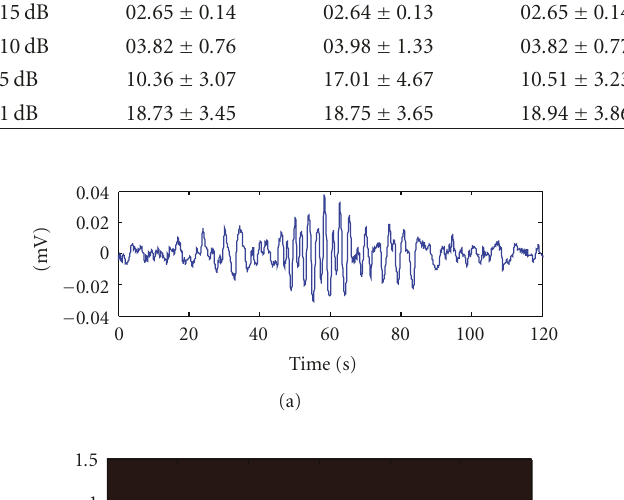
Table 4: Comparison of frequency parameters between pregnancy and labor contractions ( † and ‡ indicate a significant di ff erence of 5% and 1%, respectively between pregnancy and labor